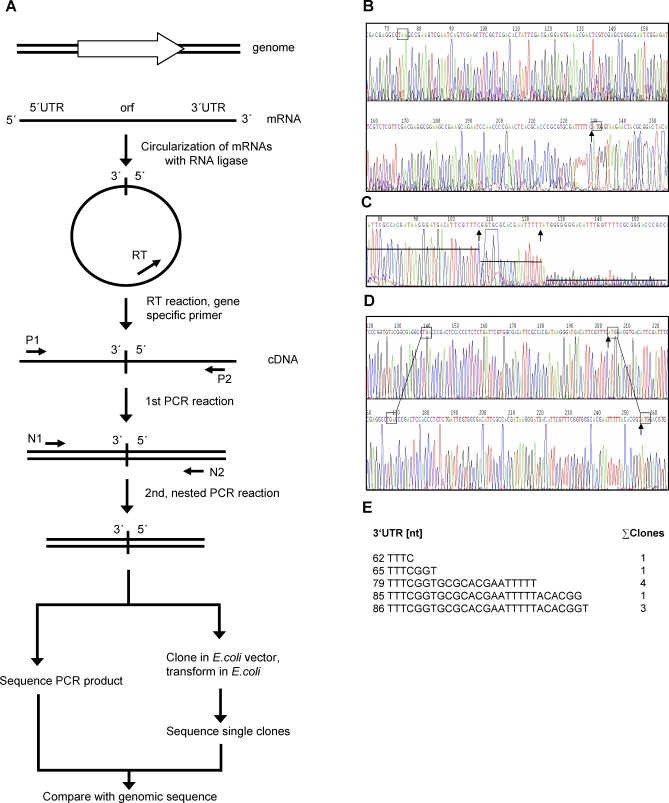
Determination of 5′- and 3′-Ends of Haloarchaeal Transcripts(A) Overview of the method. A recently developed method [28] was used to determine 5′-ends and 3′-ends of haloarchaeal transcripts. The overview schematically shows the different steps of the protocol. Circularization of transcripts with T4 RNA ligase is only possible if their 5′-ends are monophosphorylated, in contrast to the 5′- triphosphate that is present when they are newly synthesized. This led to the initial belief that only processed transcripts can be analyzed [28], but it turned out that the method is also ideally suited to characterize primary transcripts (compare Discussion).(B) Sequence of a PCR product representing a transcript with only one specific 3′-end (number 12 in Table 2). The stop and start codons of the gene are boxed, and the ligation point of the 5′-end and the 3′-end are denoted by an arrow.(C) Sequence of a PCR product representing a transcript with several 3′-ends (number 7 in Table 2). Different signal intensities are indicated by lines and the ligation point of the 5′-end and two different 3′-ends are denoted by arrows.(D) Sequences of two clones after cloning the PCR product shown in C (number 7 in Table 2). The results of two sequencing reactions of independent clones are shown. In both cases, the stop codon and start codon of the gene are boxed, and the ligation point of the 5′-end and the 3′-end are denoted by an arrow.(E) Results after sequencing ten clones. The sequences of five different 3′-ends and their number of occurrence are shown. The 5′-end was found to be identical in all ten cases.